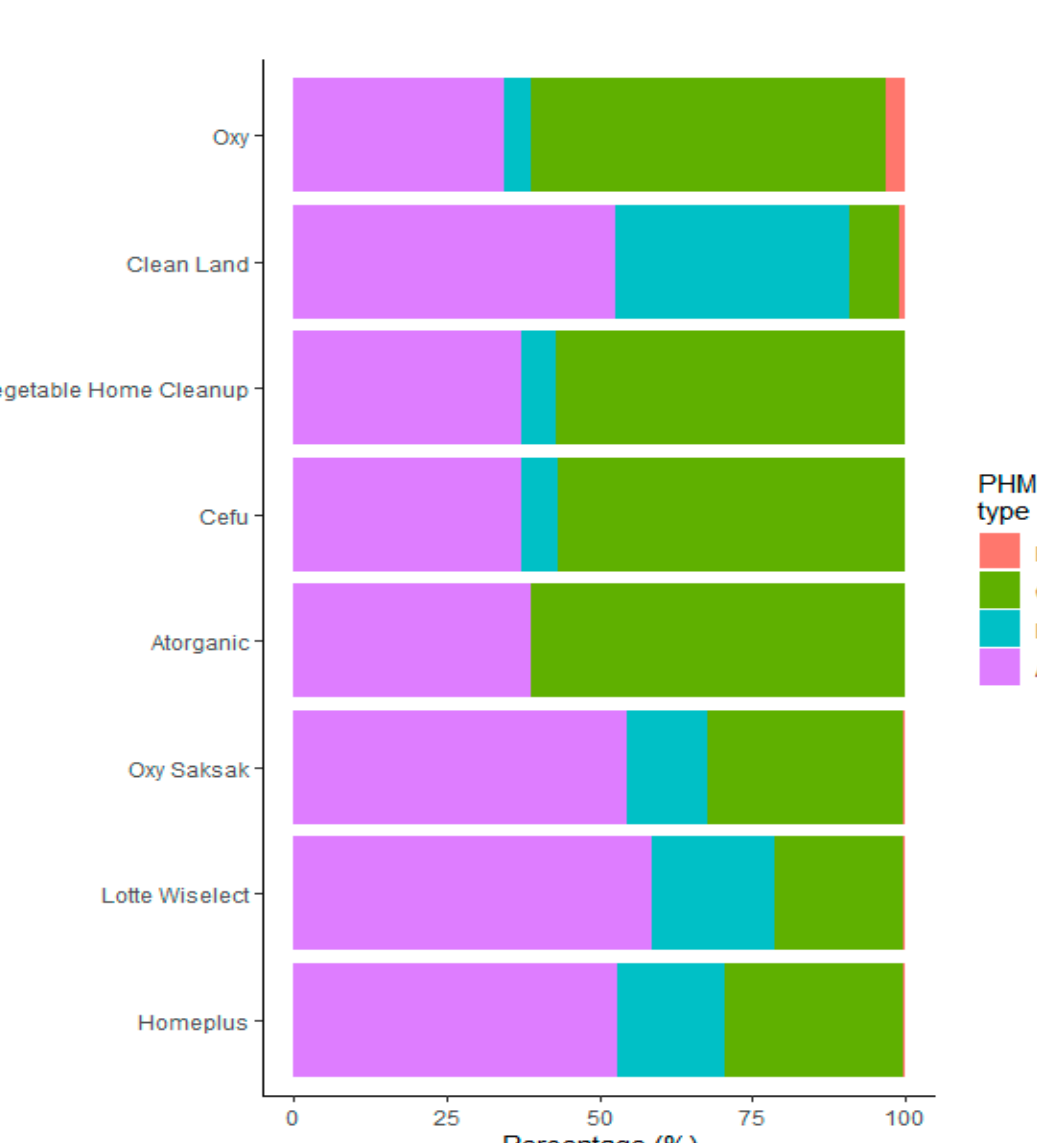
Figure 1. Structures of four isomeric types of PHMG oligomers in HD products, as identified in the MALDI ‐ TOF MS spectra.